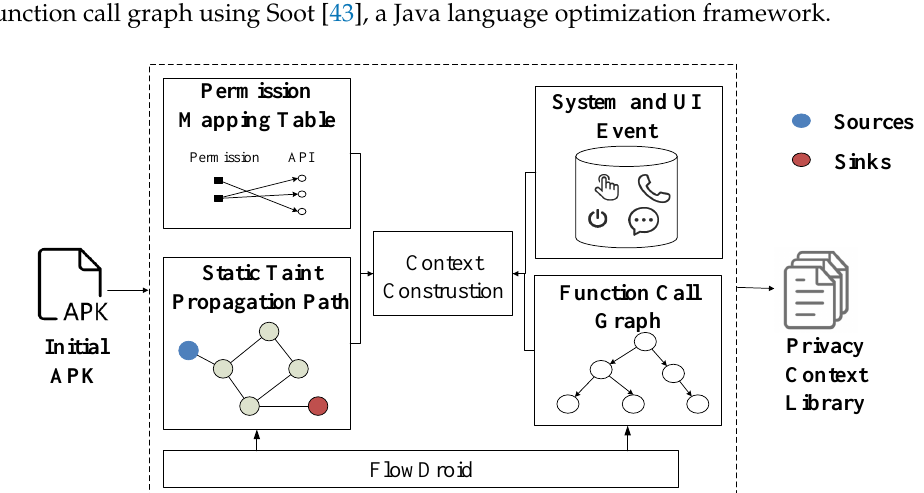
Figure 5. Frame of static privacy leakage analysis